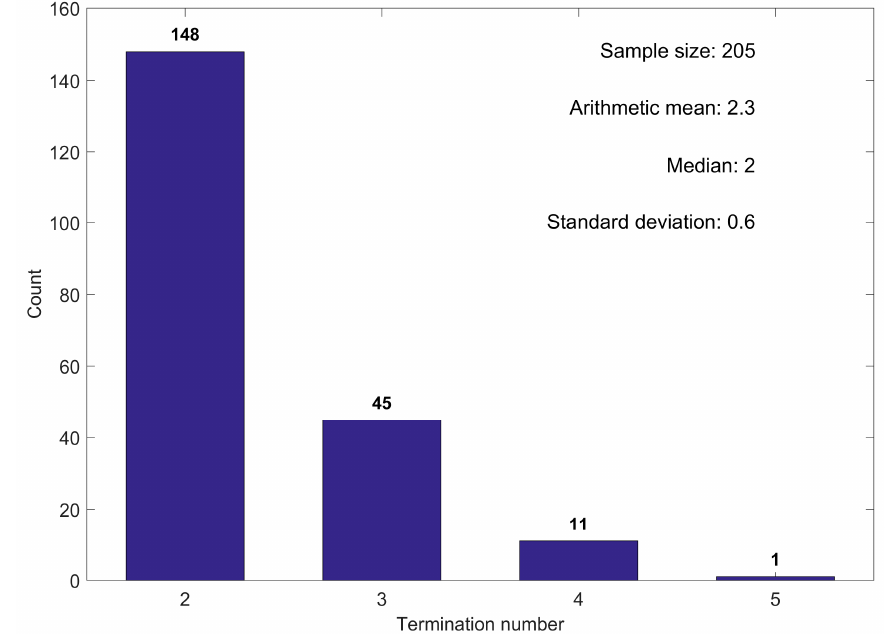
Figure 3. Histogram of termination number in each MTF.